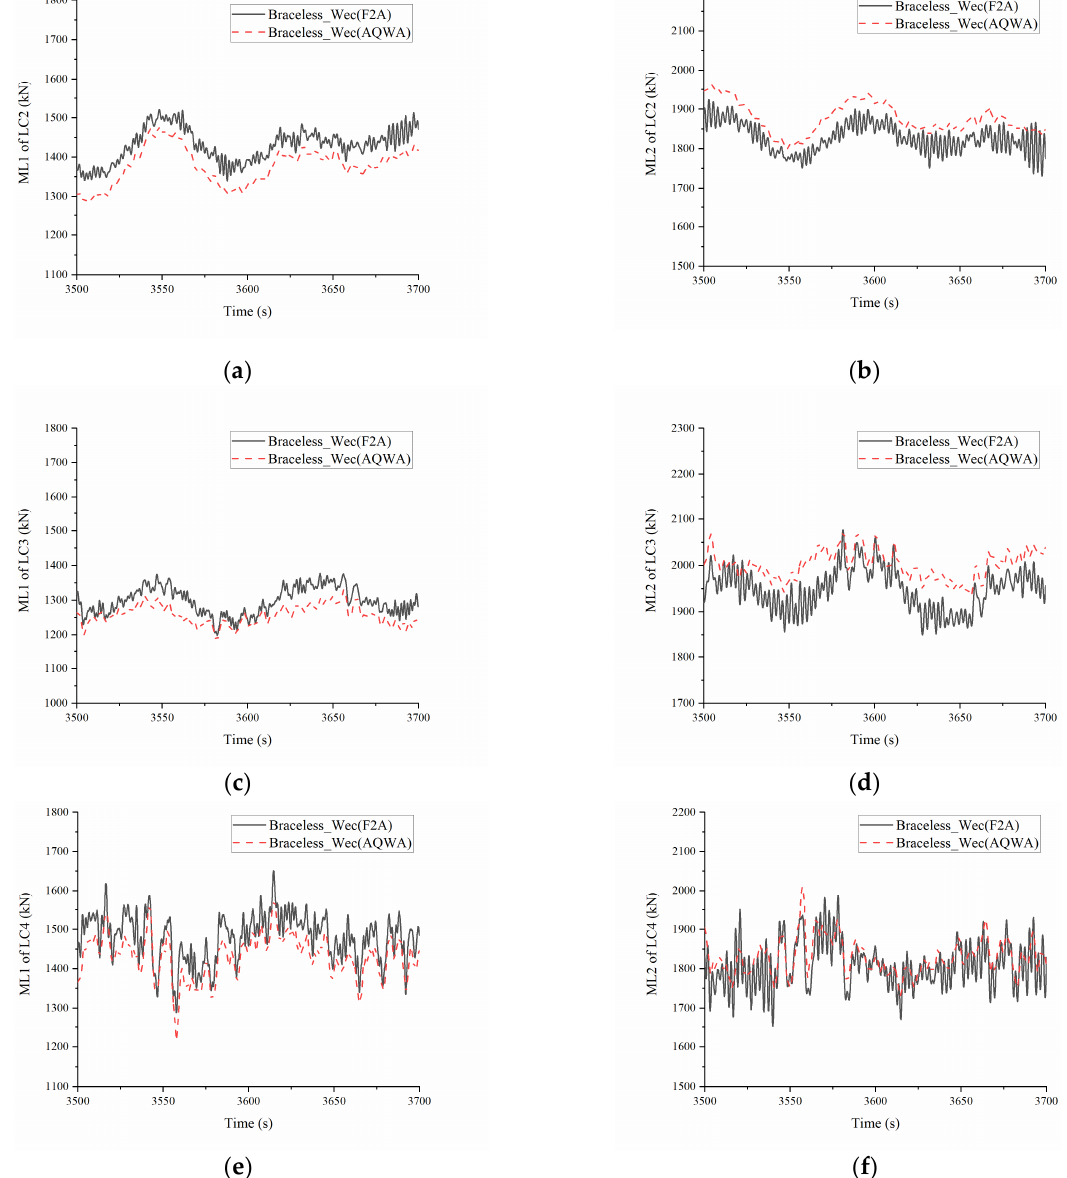
Figure 10. Mooring force of: ( a ) ML1 in LC2, ( b ) ML2 in LC2, ( c ) ML1 in LC3, ( d ) ML2 in LC3, ( e ) ML1 in LC4, ( f ) ML2 in LC4.